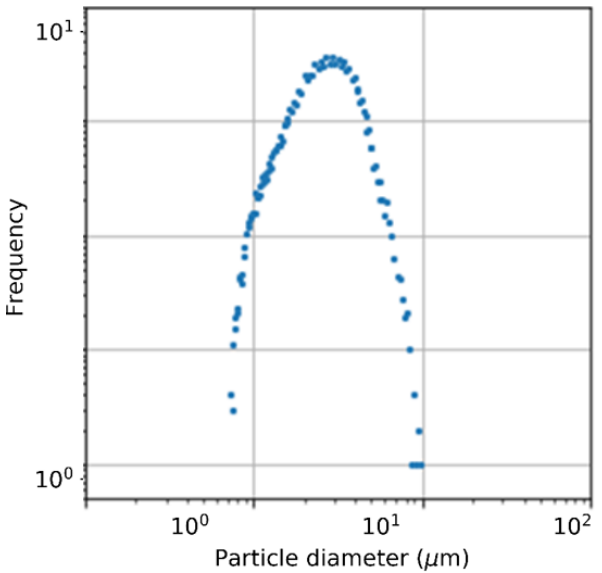
Figure A5. Size distribution of activated droplets measured with PINE-1A at high-temperature conditions where no active INPs were present.